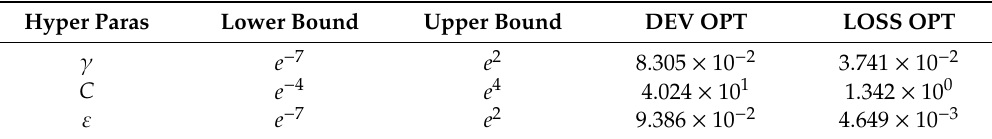
Table 3. Search domain and optimal values of hyper